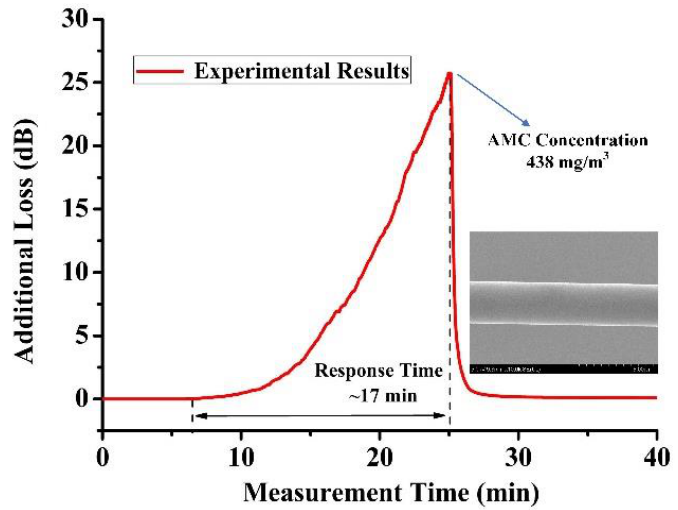
Figure 6. Response of the OMFs sensors at heating temperature of 98 °C, the inset shows the SEM image of the OMFs sensor with ~3.0 μm diameter.